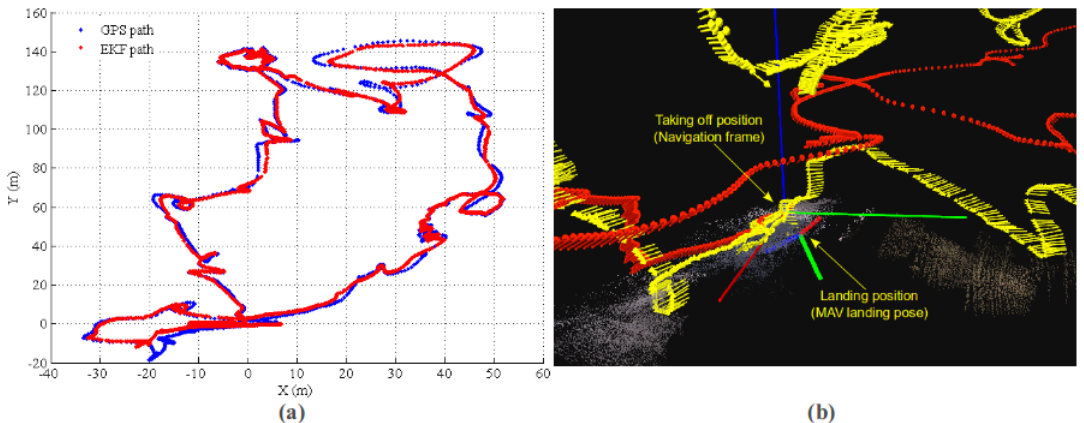
Figure 15. EKF state estimation result. ( a ) EKF estimation path in the X-Y plane; the MAV takes off at (0,0) and comes back after 12 min of flight; ( b ) local details for EKF state estimation. The yellow arrow sequence is the 3D path from EKF, and the red sequence is the GPS path. Clearly, GPS reports bad positioning information in the altitude direction.